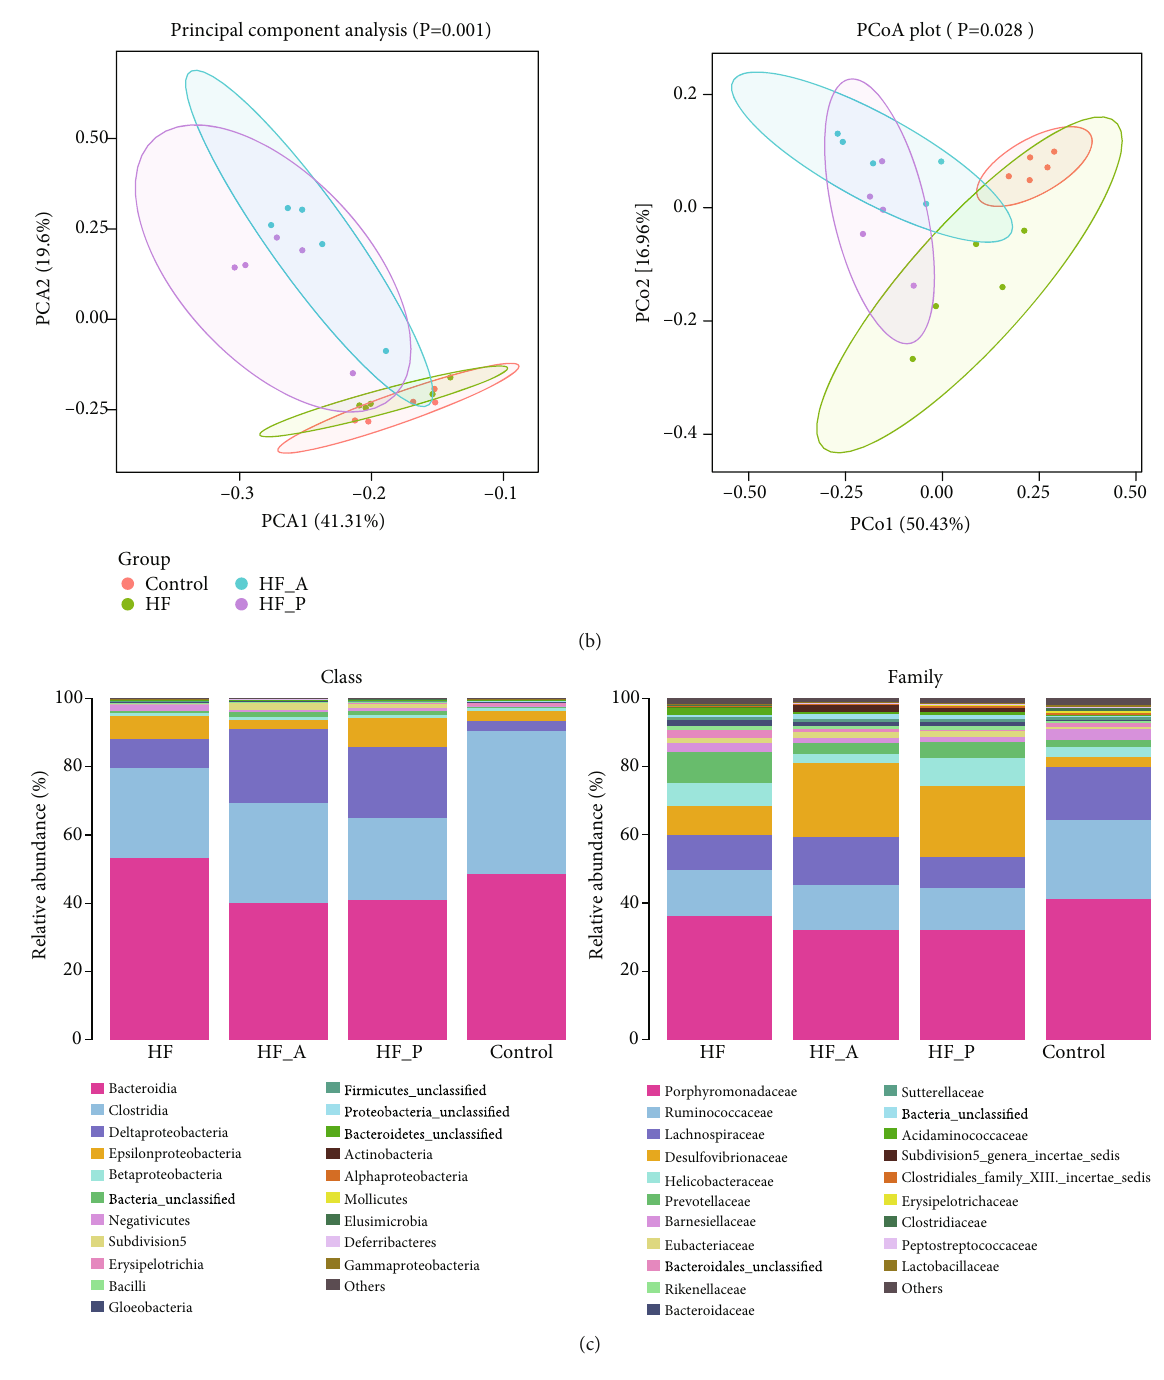
Figure 4: Probiotics improve gut microbiota in HFD-induced NAFLD: (a) Venn diagram, Shannon, and Simpson; (b) PCA and PCoA; (c) relative abundance of four groups in class and family